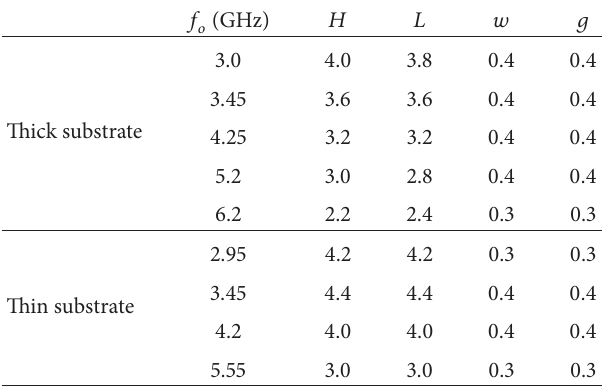
Figure 4: Wideband monopole antenna layout. Table 1: Design parameters of the multiple resonators (dimension: mm).